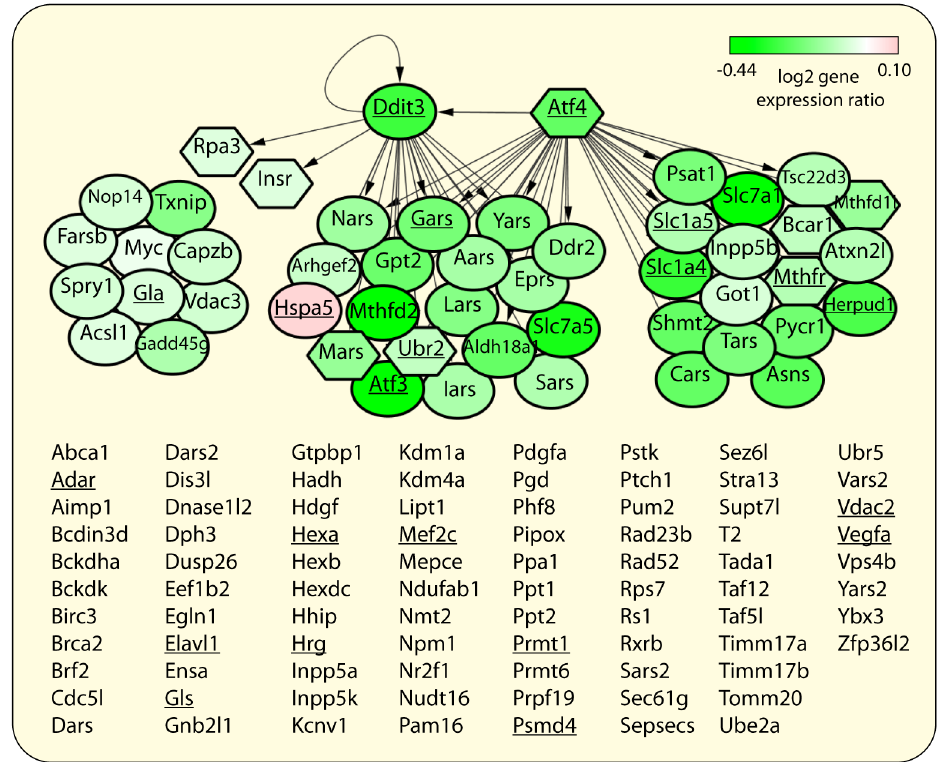
Fig 3. The 134 genes from the ALS gene expression classifier. Genes that are either transcriptionally responsiveto ER stress [32] or directly targeted by TFs ATF4 (Atf4) and CHOP (Ddit3) duringER stress [32] are shown as nodes (depictedusing Cytoscape[33]). Node color indicatesmean log 2 differentialexpression level in the indicatorcell assay (diseaseversus normal) rangingfrom –0.44 (green) to 0.1 (pink). Node shape indicatesgenesthat are transcriptionallyresponsiveto ER stress (oval) or are not (hexagon) [32]. 133 of the 134 genesare known to have humanorthologsand underlinedgenesco-occur with “amyotrophiclateral sclerosis” in titles or abstracts of articles in PubMed (on 01/15/15).